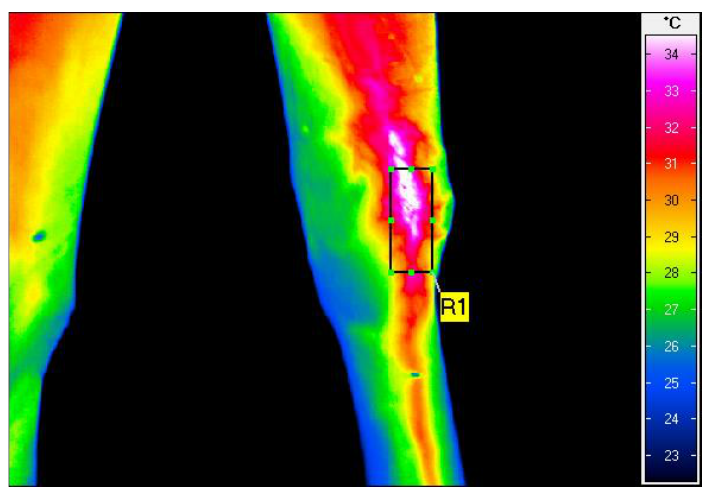
Figure 2. Thermographic image of the medial view of the right carpal joint, taken after HILT treatment in the non-clipped group. The rectangular area (R1) shows the average skin surface temperature as 31.9 ° C. Table 1. Skin surface temperature, vein diameter and differences in skin temperature and vein diameter values (median (Q1–Q3) and range (Min–Max)) before and after high-intensity laser therapy (HILT) application to horses with clipped and non-clipped